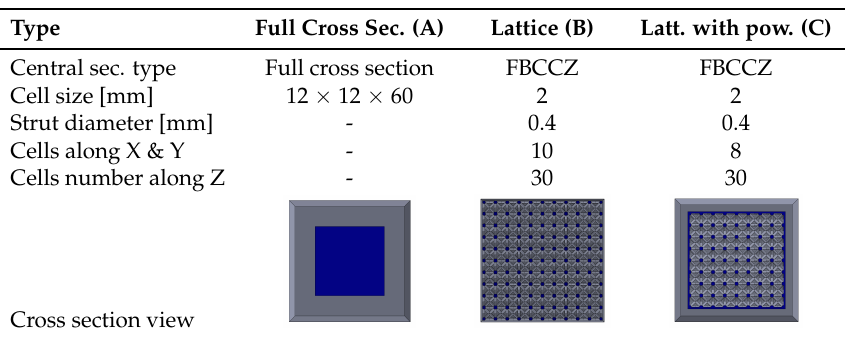
Table 1. Summary of specimens’ geometrical features